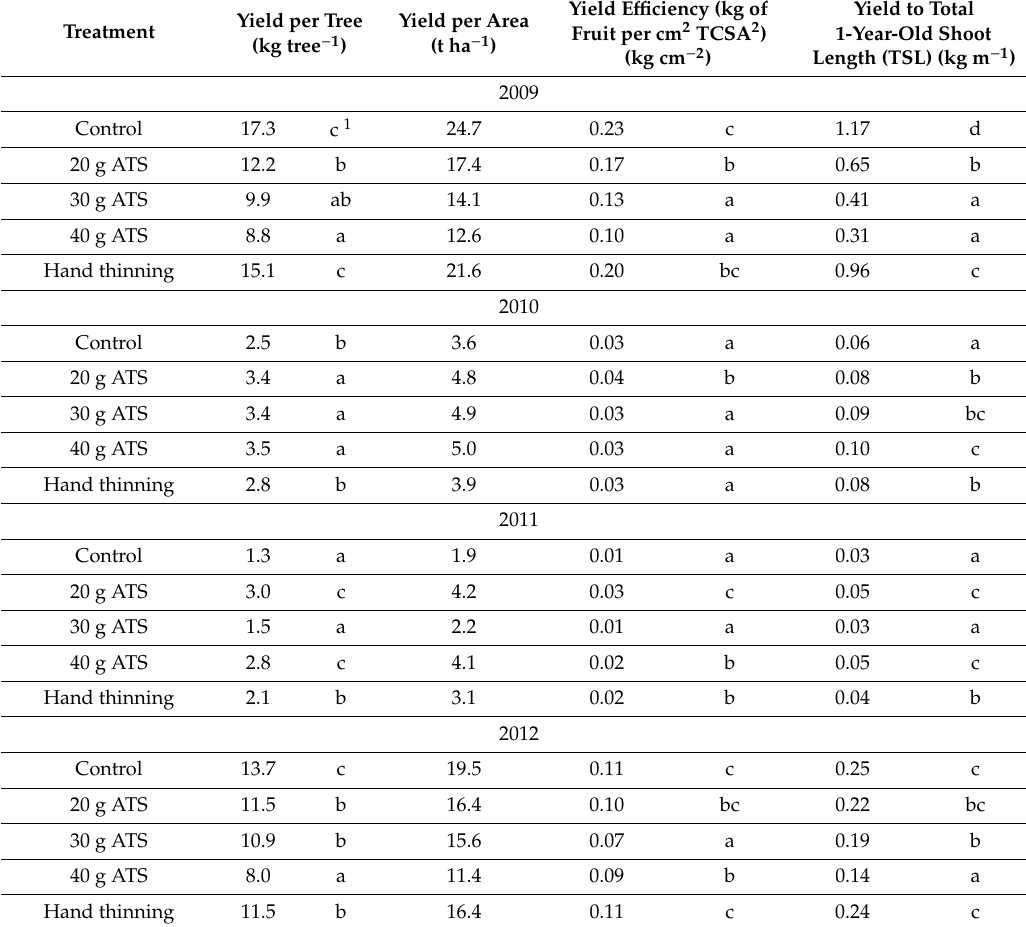
Table 4. The e ff ect of thinning on productivity parameters of Regina sweet cherry trees in 2009–2012.